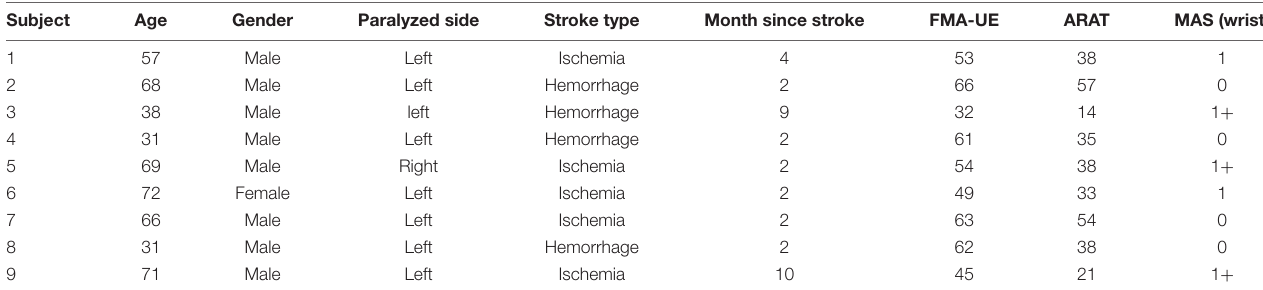
TABLE 1 | Clinical characteristics of stroke